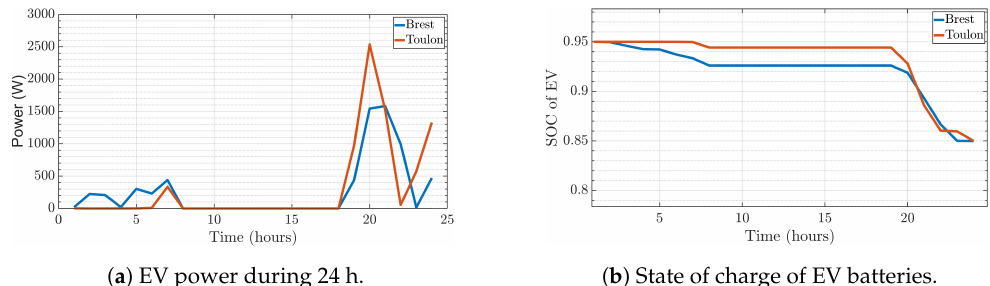
( a ) EV power during 24 h. ( b ) State of charge of EV batteries. Figure 12. Case study 2: EV batteries power and state of charge for Brest and Toulon.